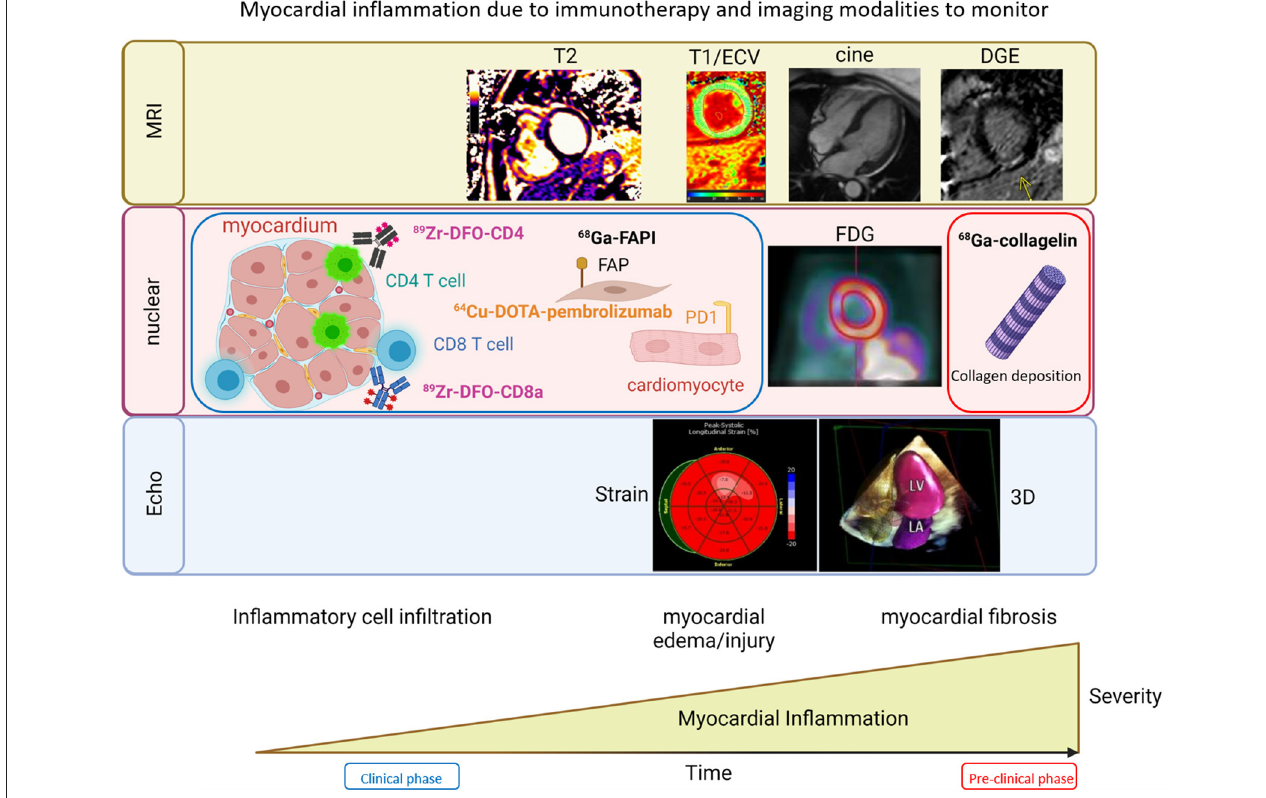
FIGURE 3 | Imaging modalities in the evaluation of immunotherapy related cardiotoxicities. Imaging modalities that can be used to monitor myocardial inflammation due to immunotherapy include: MRI (top) using tissue characterization assessments such as T2, T1/ECV, delayed gadolinium enhancement (DGE) and cine to evaluate wall motion and function; Nuclear Imaging (middle) approaches involving molecularly targeted probes conjugated to radiotracers facilitating evaluation of CD4 cells with 89 Zr-DFO-CD4, CD8 cells with 89 Zr-DFO-CD8, early signs of fibrosis with fibroblast activation protein (FAP), expression of PD1 on cardiomyocytes, which can be seen with 64 Cu-DOTA-pembrolizumab and may reflect increased risk of checkpoint inhibitor myocarditis, FDG that allows for monitoring of inflammation, and the final stages of inflammation with tissue damage and fibrosis and scar deposition assessed with collagen imaging with 68 Ga collagelin; Echocardiography (bottom) is able to evaluate regional and global strain to detect signs of chemotherapy related toxicity and